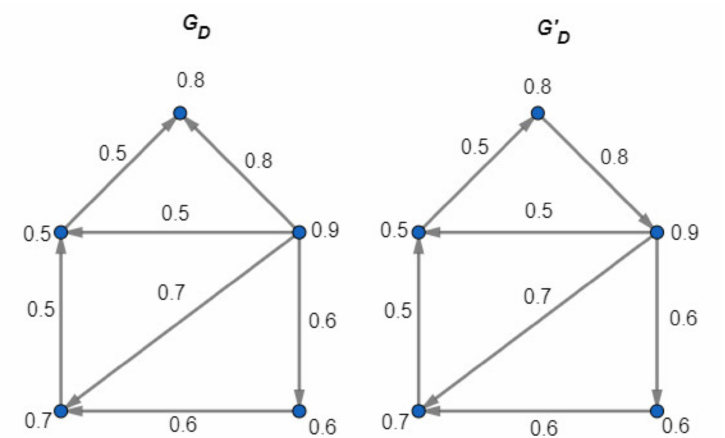
Figure 7. The minimum dominating set of G D is { 0.9 } , that is, γ ( G D ) = 0.9 and the minimum dominating set of G D (cid:48) is { 0.5,0.9 } , that is, γ ( G D (cid:48) ) =